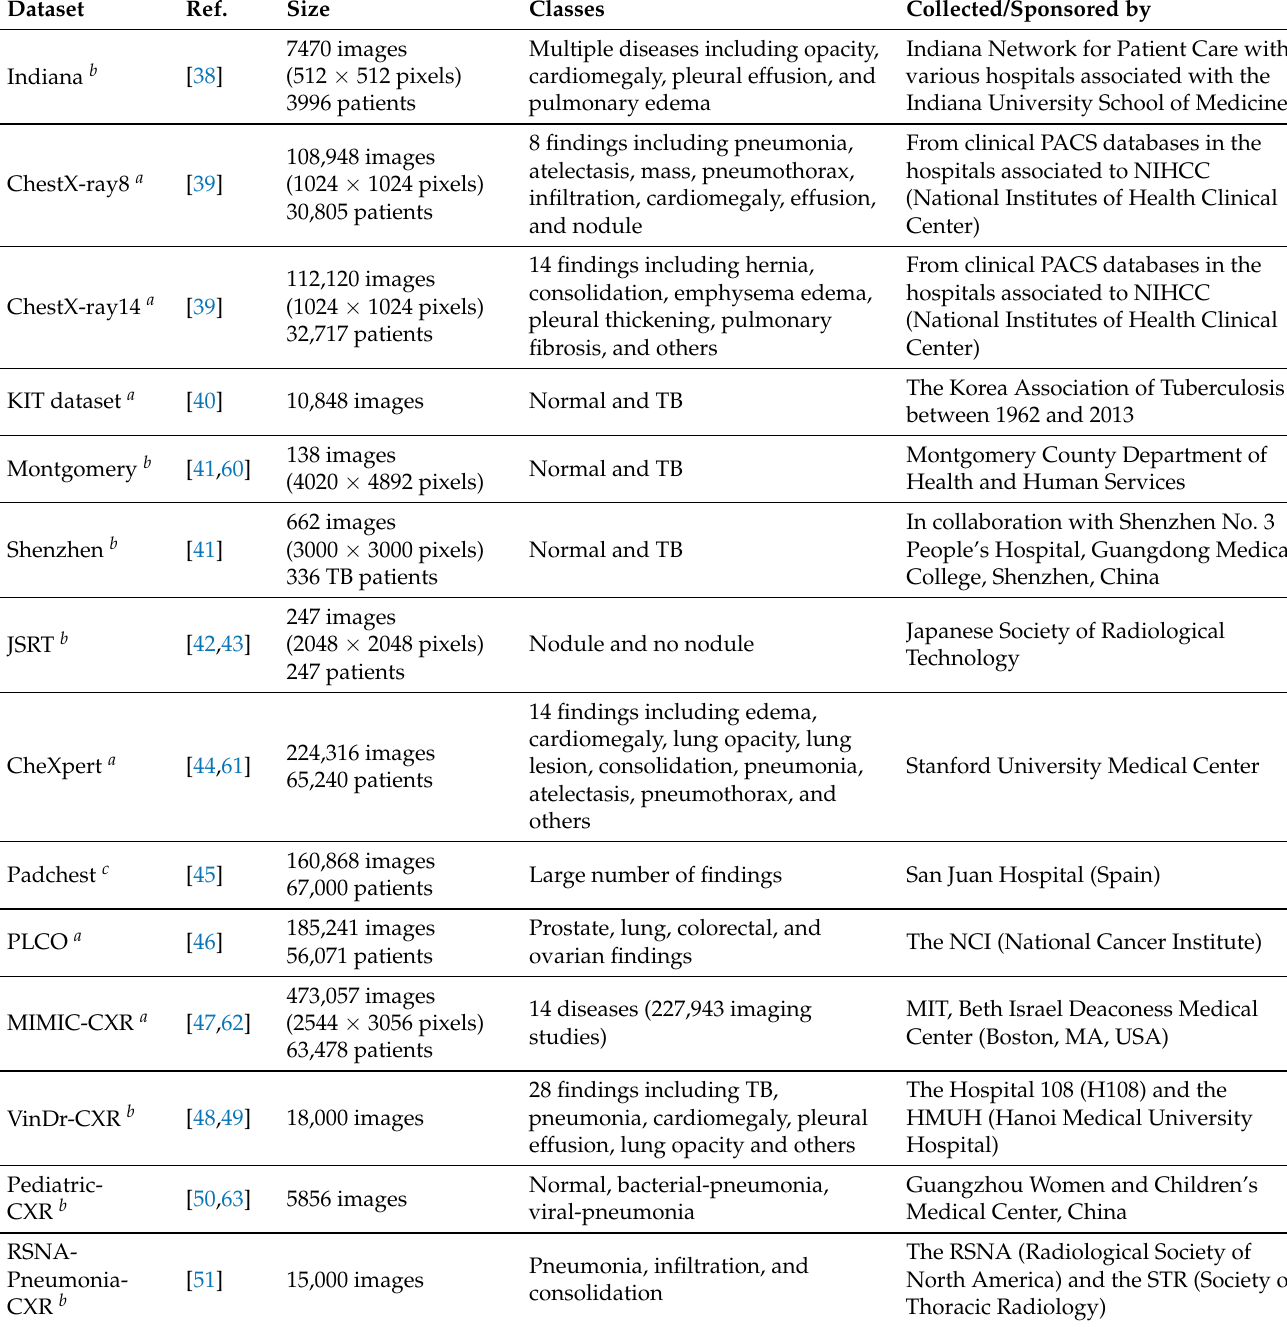
Table 1. Publicly available CXR